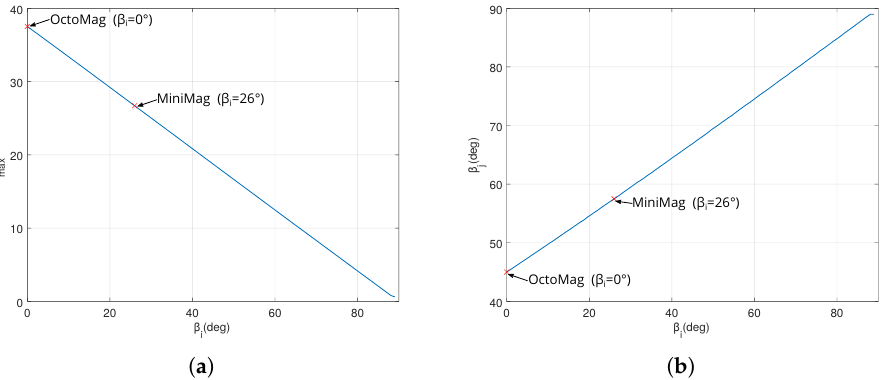
Figure 8. Evolution of ( a ) admissible radius r max and ( b ) the mobile angle β j when the contact constraints are